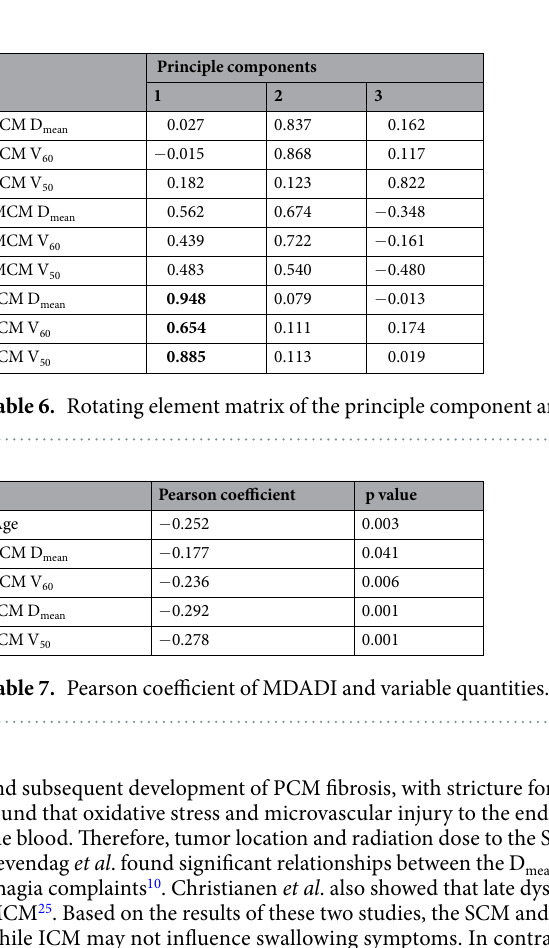
Figure 2. ROC curve of the dosimetric parameters for grade 2 late dysphagia.